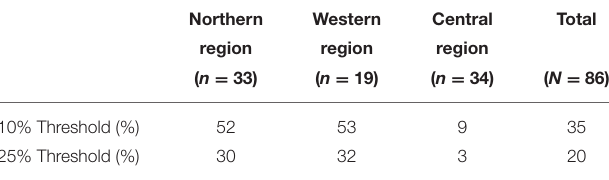
TABLE 3 | Percentage of households experiencing catastrophic health expenditure by